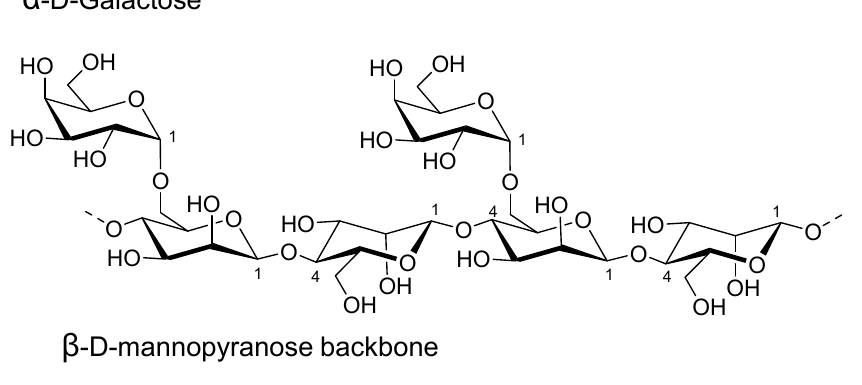
Figure 7. Guar gum structure.